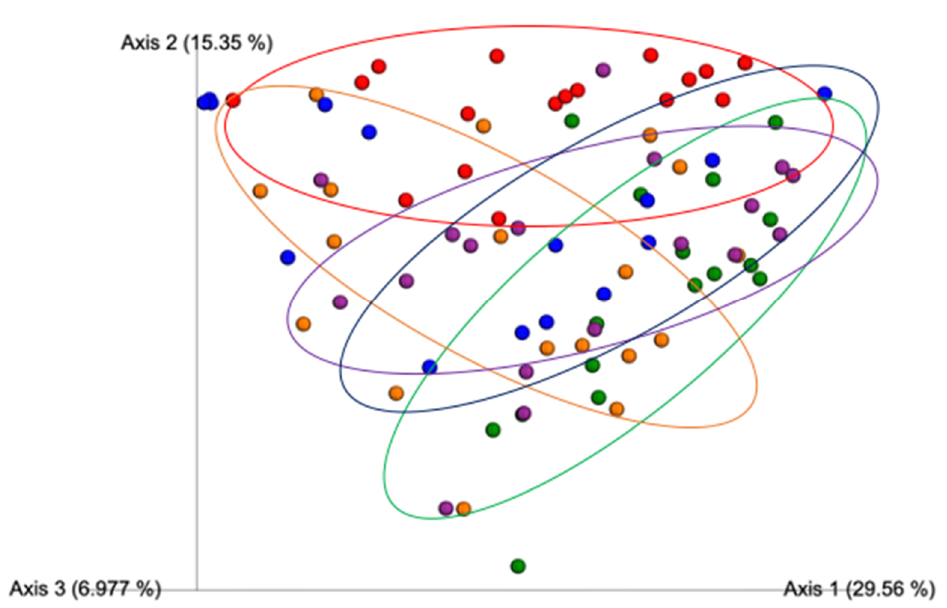
Figure 4. Beta diversity PCoA plot of between-group distances using Bray–Curtis distance matrix values. Treatment groups are as follows: control, red; high-fat, high-sugar diet (HFD), blue; HFD + genistein (Gen), purple; HFD + exercise (Exe), orange; HFD + Exe + Gen, green. Significant group differences ( p < 0.05) after Benjamini–Hochberg correction for multiple comparisons were observed for all pairwise treatment comparisons.